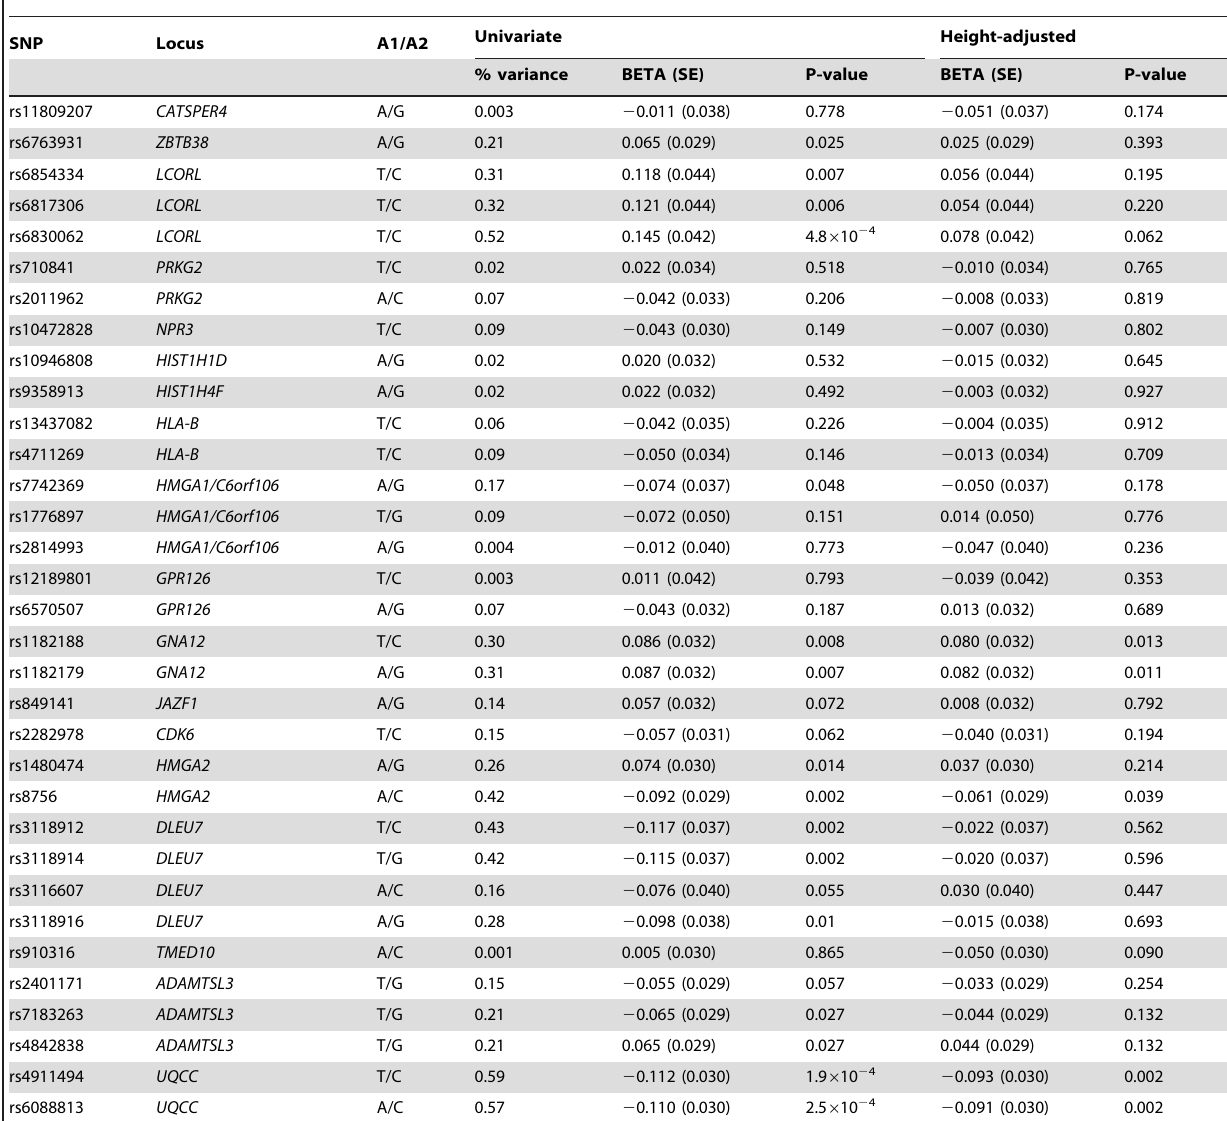
Table 3. Association of validated height loci with hip axis length